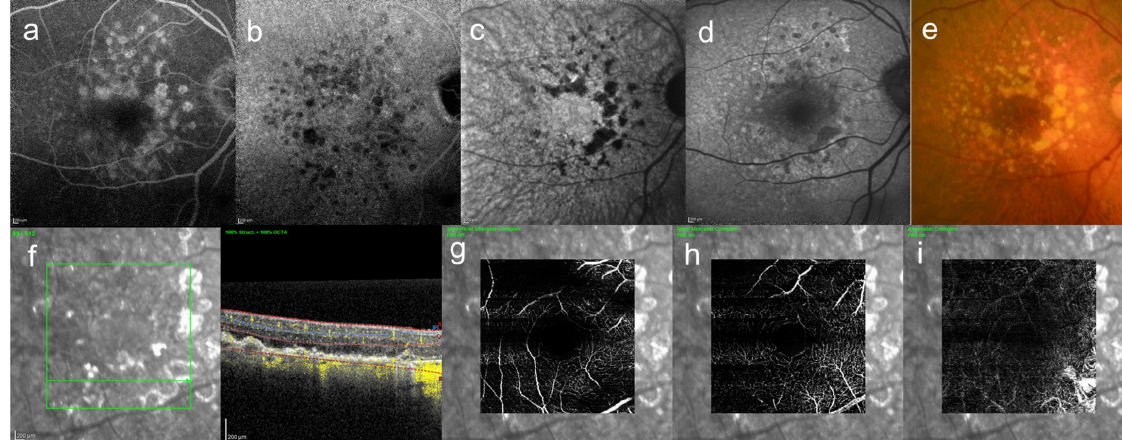
Figure 4. An 85-year-old woman with AMD. These images are the right eye with 20/16. This patient came to the hospital with a complaint of contralateral gradual loss of vision 4 months ago. No other systemic diseases. ( a ) FA image acquired at 16 min, increasing fluorescence throughout the angiogram but the margins remain distinct, ( b ) ICGA image, abnormal hypofluorescence contrast became clearer acquired at 26 min, ( c ) near-infrared autofluorescence image, abnormal hypofluorescence can be seen broadly which corresponds to the hypofluorescent area of ICGA images, ( d ) short-wavelength fundus autofluorescence image, abnormal hyperfluorescence and confluent hypofluorescence can be seen broadly, ( e ) color fundus photograph, drusen and geographic atrophy can be seen broadly, ( f ) infrared + OCT angiography (horizontal section) through the drusen, ( g ) Superficial vascular segment OCT angiography, ( h ) Deep vascular segment OCT angiography, ( i ) Avascular segment OCT angiography, ( g – i ) where there is no macular neovascularization, but enlarged choroidal vessels ( i ).